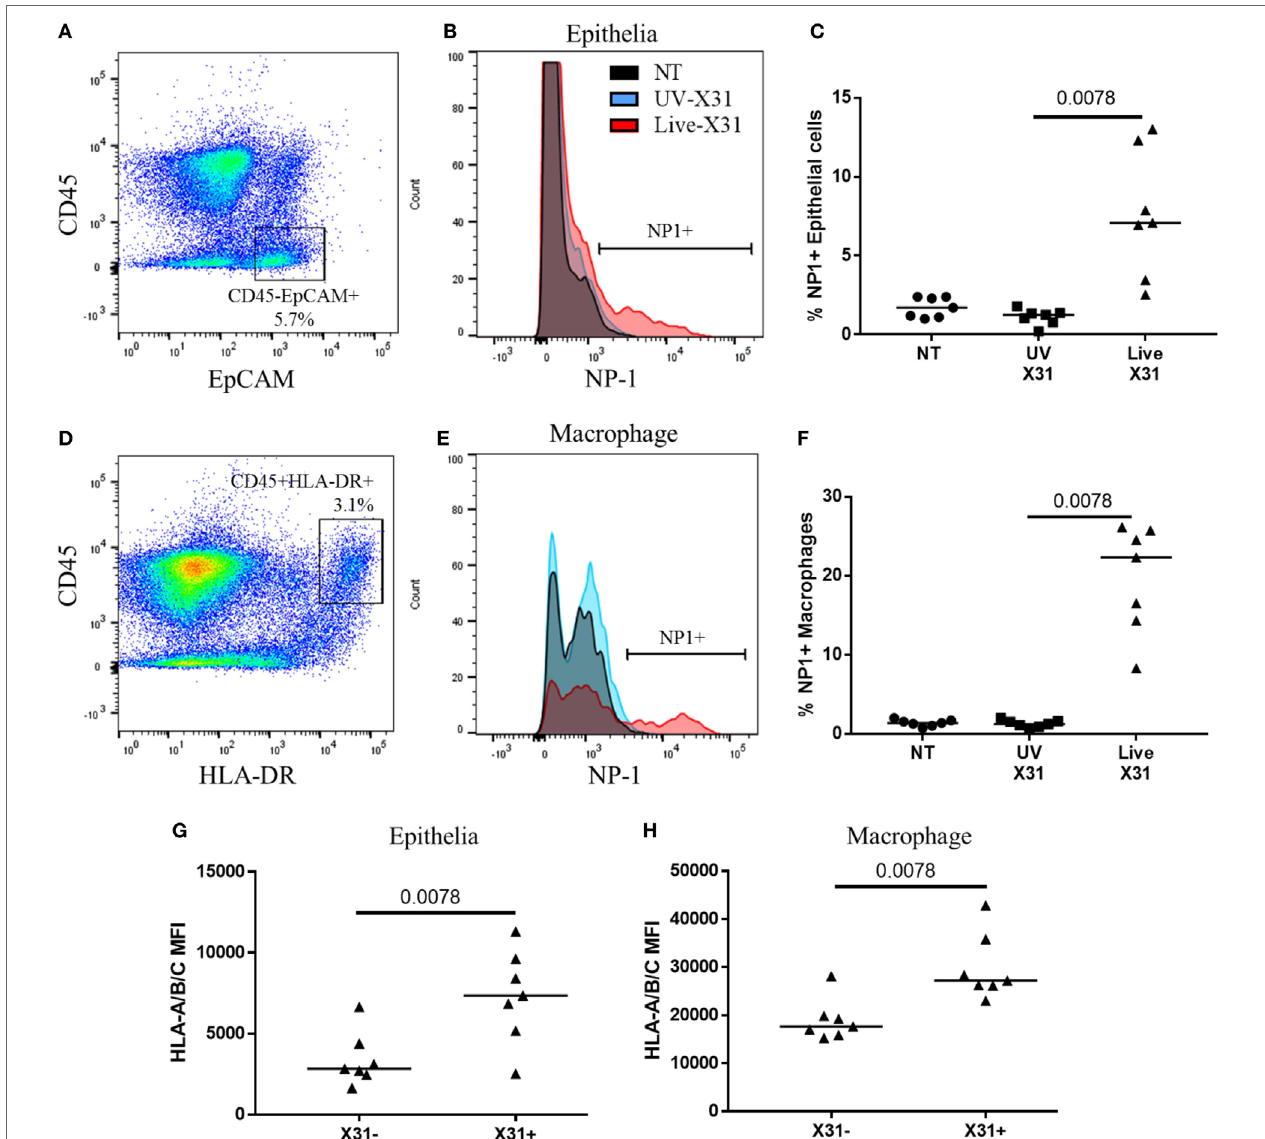
FigUre 6 | Influenza X31 infection in human lung explants. (a) Representative flow cytometry plot defining lung epithelia as CD45 − EpCAM + cells. (B,c) Influenza nucleoprotein-1 (NP1) expression in X31-infected epithelia. (D) Representative flow cytometry plot defining lung macrophages as CD45 + HLA-DR + cells. (e,F) Influenza NP1 expression in X31-infected macrophages. (g,h) Expression of HLA-A/B/C on epithelial cells (g) and macrophages (h) with and without X31 infection, as defined by NP1 expression. Lines describe medians, statistical analyses performed by Wilcoxon signed-rank test ( N =